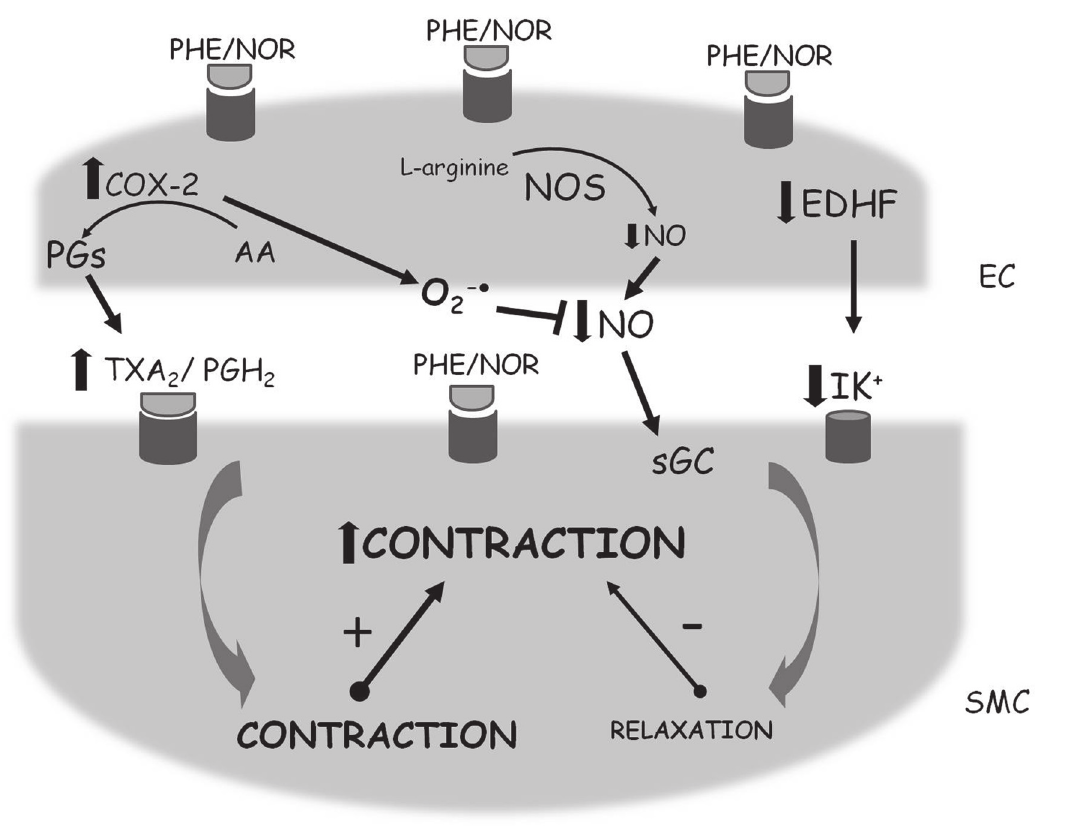
Figure 2. Schematic presentation of the effects elicited by α-adrenoceptor activation in endothelial (EC) and vascular smooth muscle cells (SMC) of small arteries from Wistar rats and spontaneously hypertensive rats (SHR) chronically treated with ouabain. AA = Arachi- donic acid; COX-2 = cyclooxygenase-2; EDHF = endothelium-derived hyperpolarizing factor; NO = nitric oxide; NOR = noradrenaline; NOS = nitric oxide synthase; O 2 -· = superoxide anion; PGH 2 = prostaglandin H 2 ; PGs = prostaglandins; PHE = phenylephrine; sGC = soluble guanylate cyclase; TxA 2 = thromboxane A 2 . ! = increase; ! = decrease; Z = production and/or stimulation; =